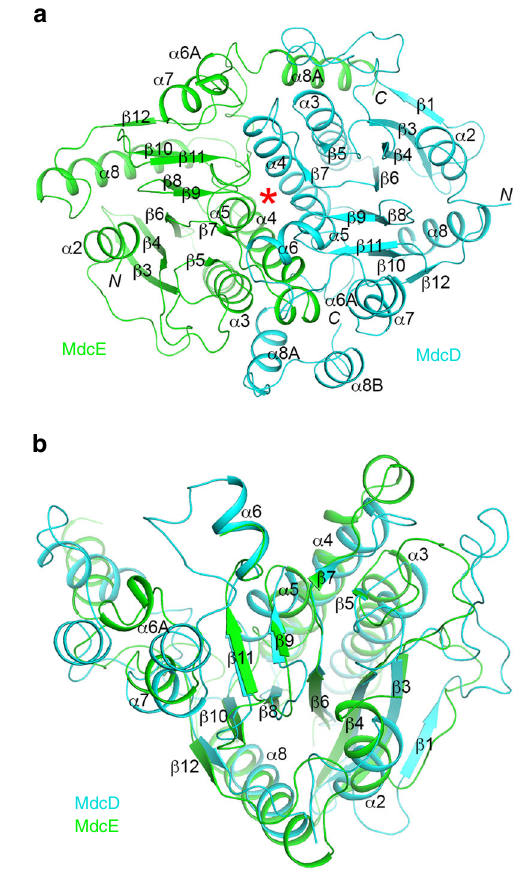
Figure 2 Structure of the MdcD – MdcE complex. a Schematic drawing of the structure of the P. aeruginosa MdcD – MdcE complex. MdcD is shown in cyan , and MdcE in green . The secondary structure elements are named following the convention of yeast ACC CT domain. The active site is indicated with the red asterisk . b Overlay of the structures of MdcD ( cyan ) and MdcE ( green ). The β -strands in the β – β – α superhelix are mostly superposed. All structure fi gures were produced with the program PyMOL